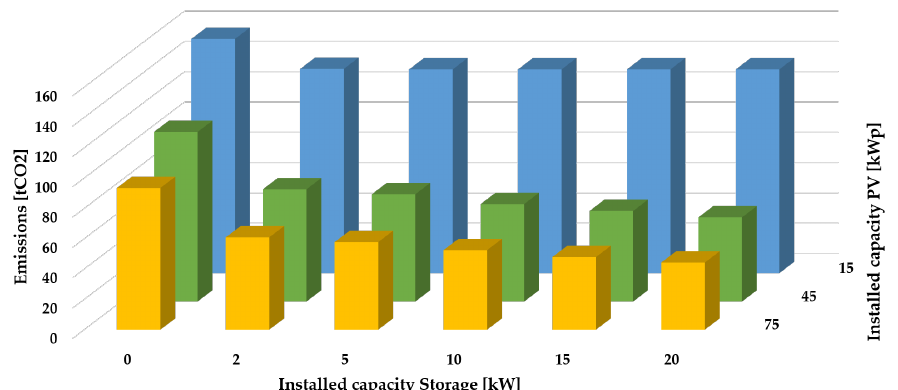
Figure 9. Cost analysis for LEC scenario with storage.